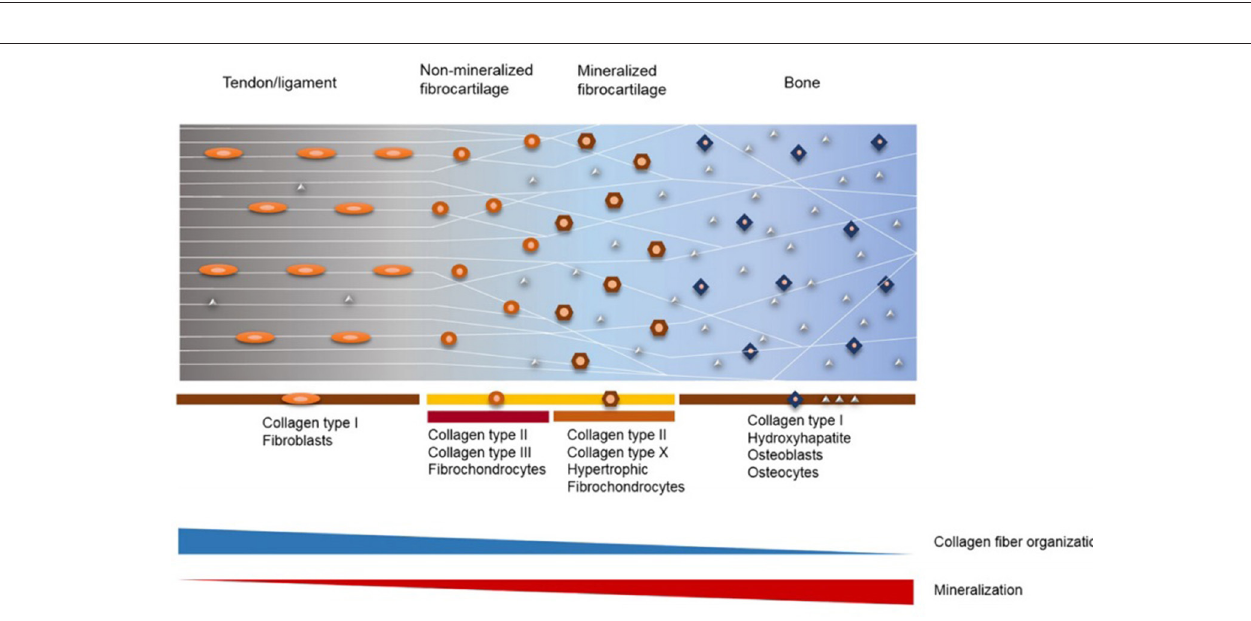
FIGURE 1 | Tendon-to-bone interface, across a functionally graded fibrocartilaginous transition site (toluidine blue-stained section from a rat supraspinatus tendon-to-bone insertion is shown; scale Bar = 200 µ m). (Reprinted by permission from Nature Publisher Group, IBMS BoneKEy, Thomopoulos, 2011 copyright © 2011).